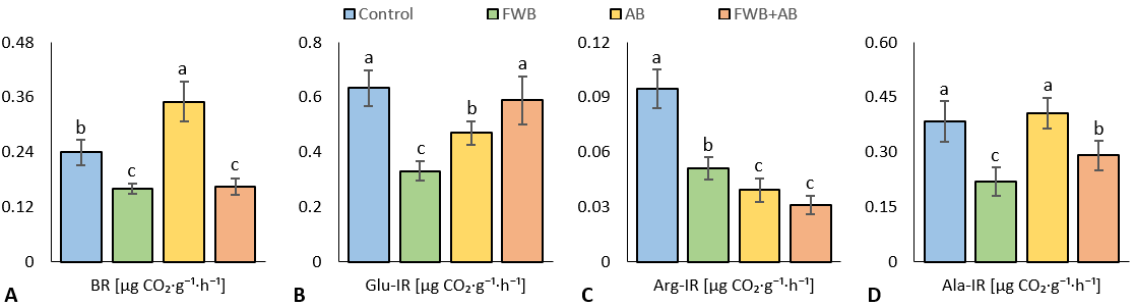
Figure 4. The responses of soil basal ( A ) and substrate-induced respiration ( B – D ) under the applied amendments. Different lowercase letters indicate statistically significant differences within columns. n = 3.